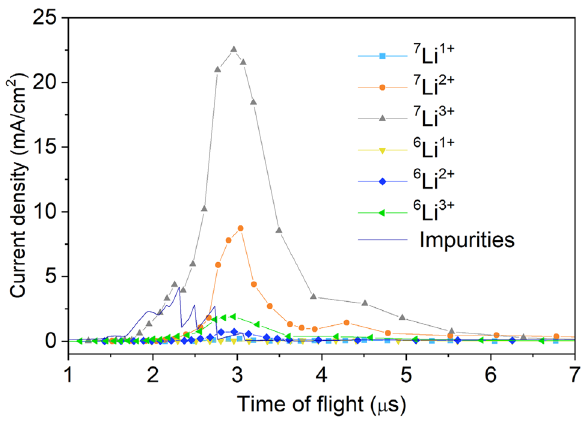
Figure 8. Analyzed ion charge state distribution. This is a temporal profile of ion current density analyzed by an EIA and scaled at 1 m away from a lithium foil using Eq. (1) and (2). The laser irradiation condition described in the section “Generation of fully stripped lithium beam” was used. By integrating each current density, the fractions of ions in the plasma shown in Fig. 3 were calculated.